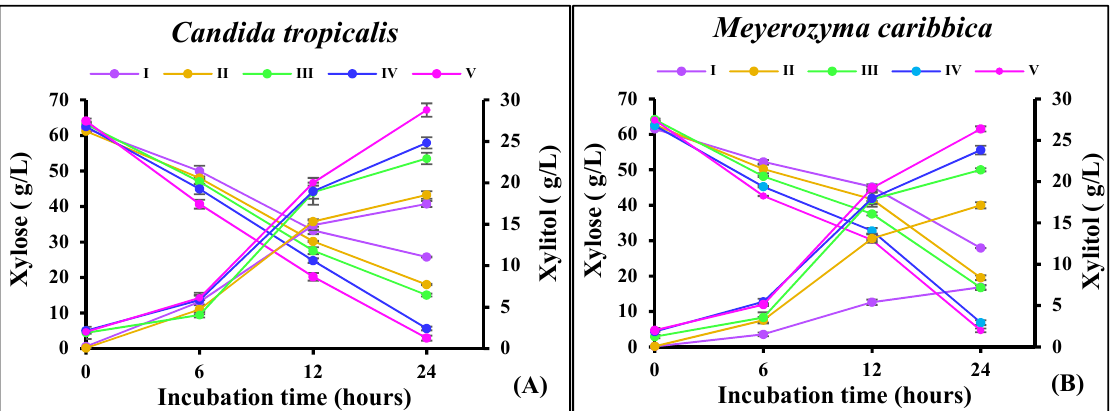
Figure 3. Xylose assimilation and xylitol production profiles in repeated batch fermentation by ( A ) C. tropicalis, ( B ) M. caribbica in rice straw hydrolysate medium. First cycle (I), second cycle (II), third cycle (III), fourth cycle (IV), and fifth cycle (V).